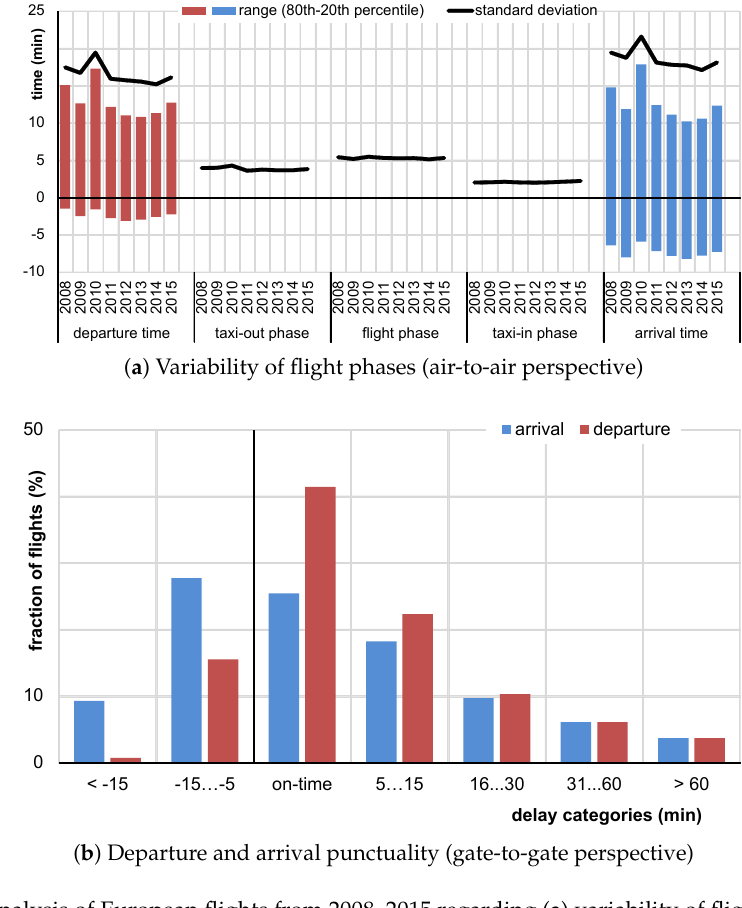
Figure 1. Analysis of European flights from 2008–2015 regarding ( a ) variability of flight phases and ( b ) punctuality, not considering flights departing to or arrival from outside Europe (for data, see